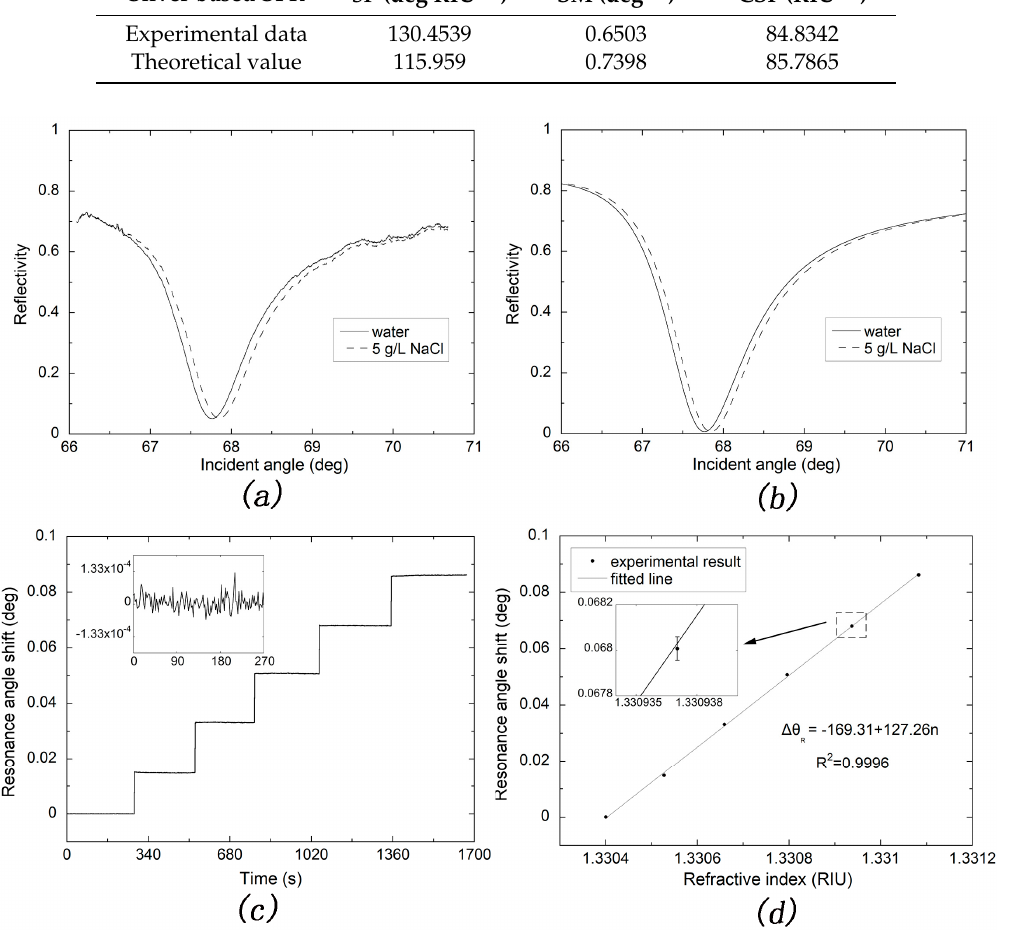
Table 1. The characteristics of silver-based SPR sensor measured with water and 5 g/L NaCl solution. Sensitivity factor (CSF); sensitivity factor (SF); sensor merit (SM). Silver-based SPR